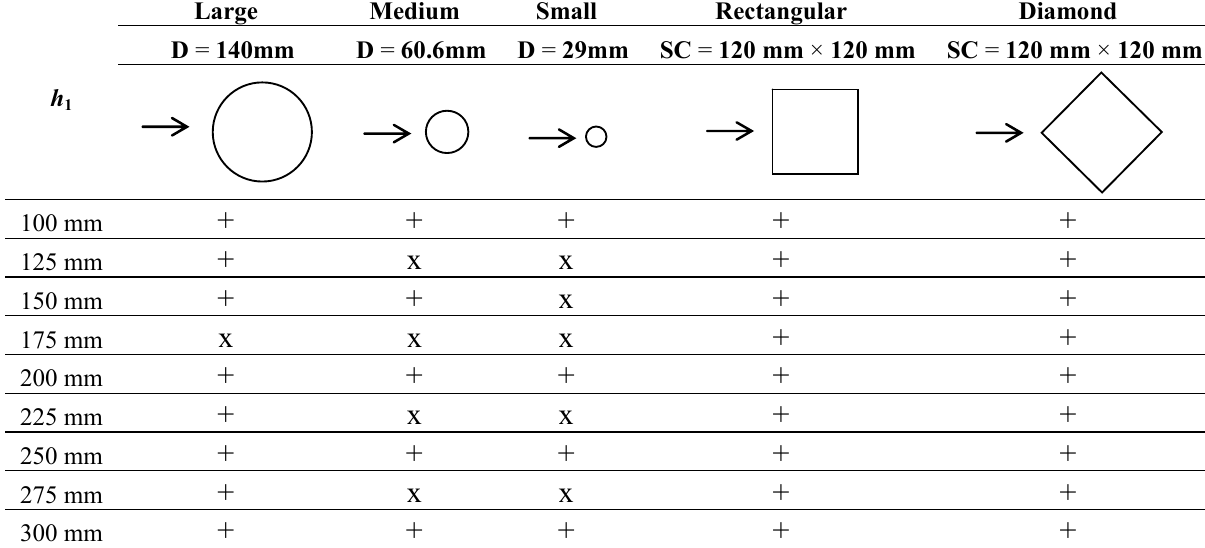
Table 1. Test matrix of